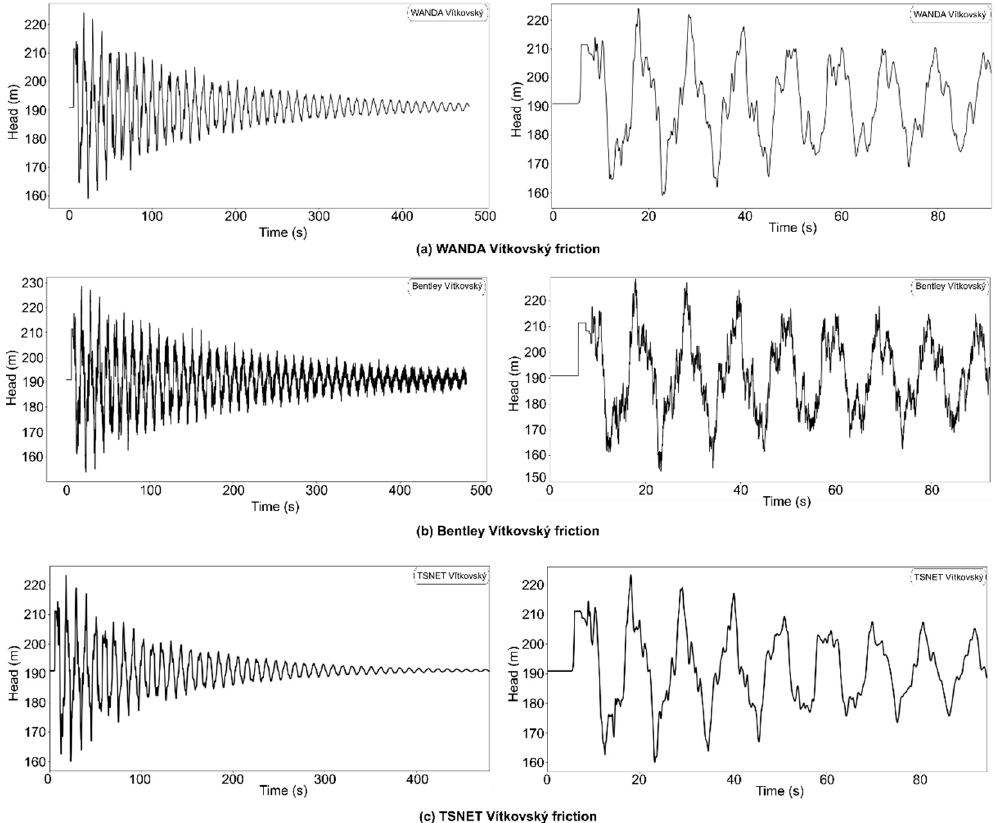
Figure 7. Comparison of Vítkovský friction in commercial software. ( a ): Wanda Vítkovský friction; ( b ): Bentley Vítkovský friction; ( c ): TSNet Vítkovský friction.